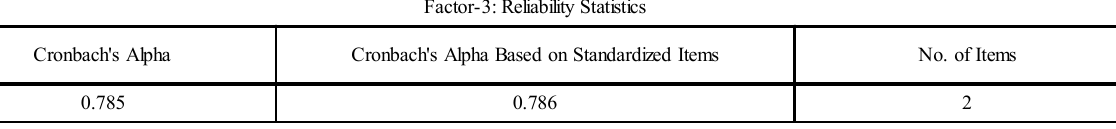
TABLE 24. FACTOR-3; DETAILS OF RELIABILITY